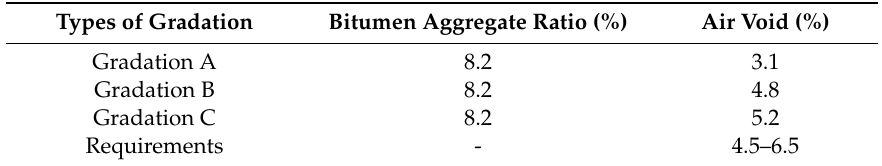
Table 11. Volume analysis of preliminary grading.